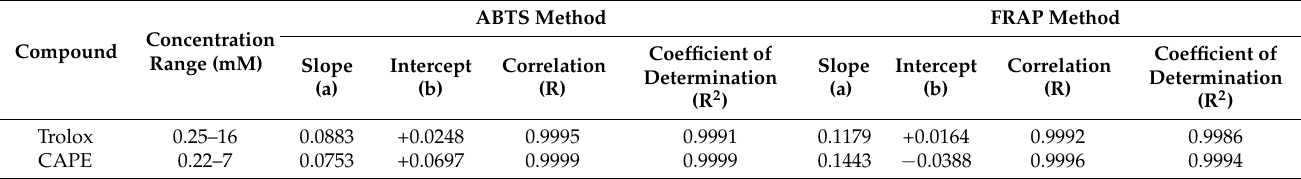
Table A1. Calibration curve (y = ax + b) data obtained by ABTS and FRAP assays for the tested compounds. Concentration Compound Range (mM)